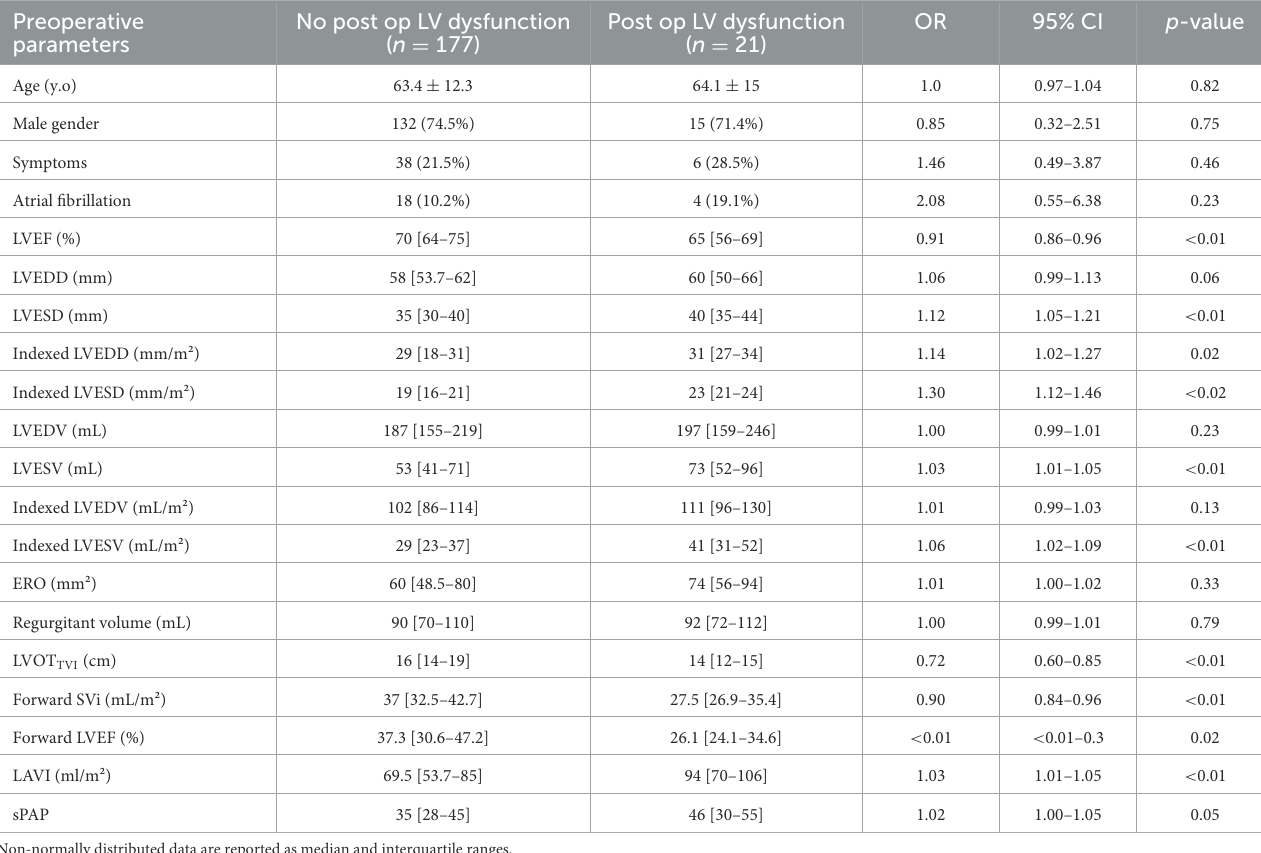
TABLE 3 Univariate risk factor analysis for predicting post-operative LV systolic dysfunction in 198 patients undergoing mitral valve repair for severe DMR. Preoperative parameters